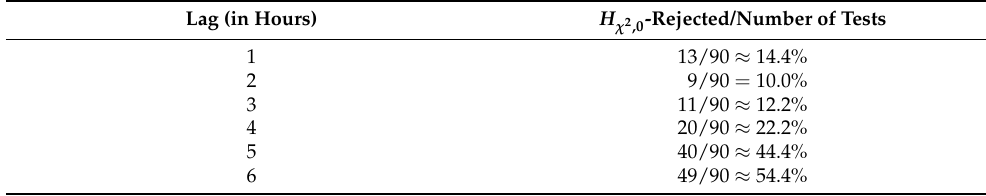
Table 13. Lags and H χ 2 ,0 rejection ratios for all monitored hives.